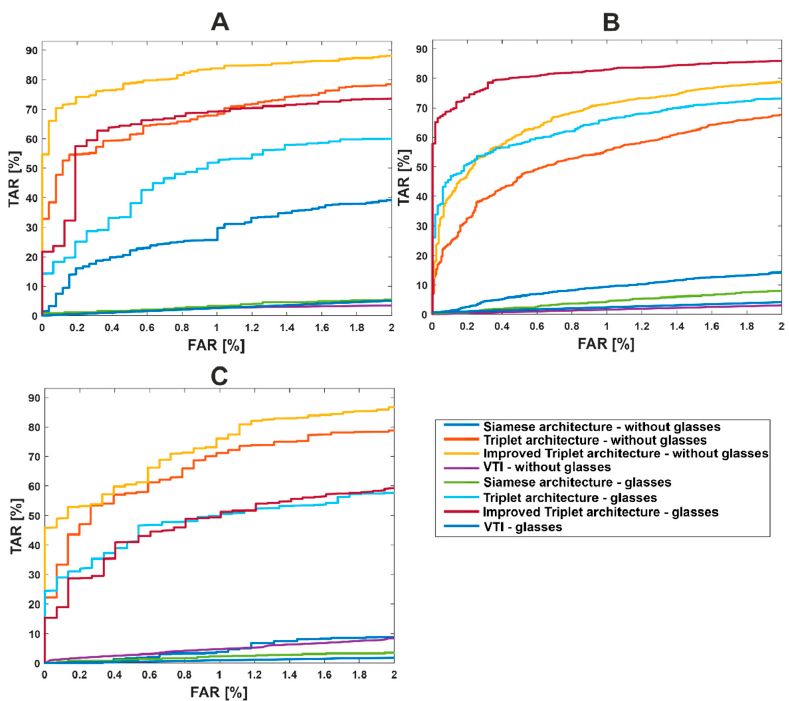
Figure 7. ROC curves for each of investigated approaches using the joint database ( A ), Speaking Faces ( B ), and Sejong Face ( C